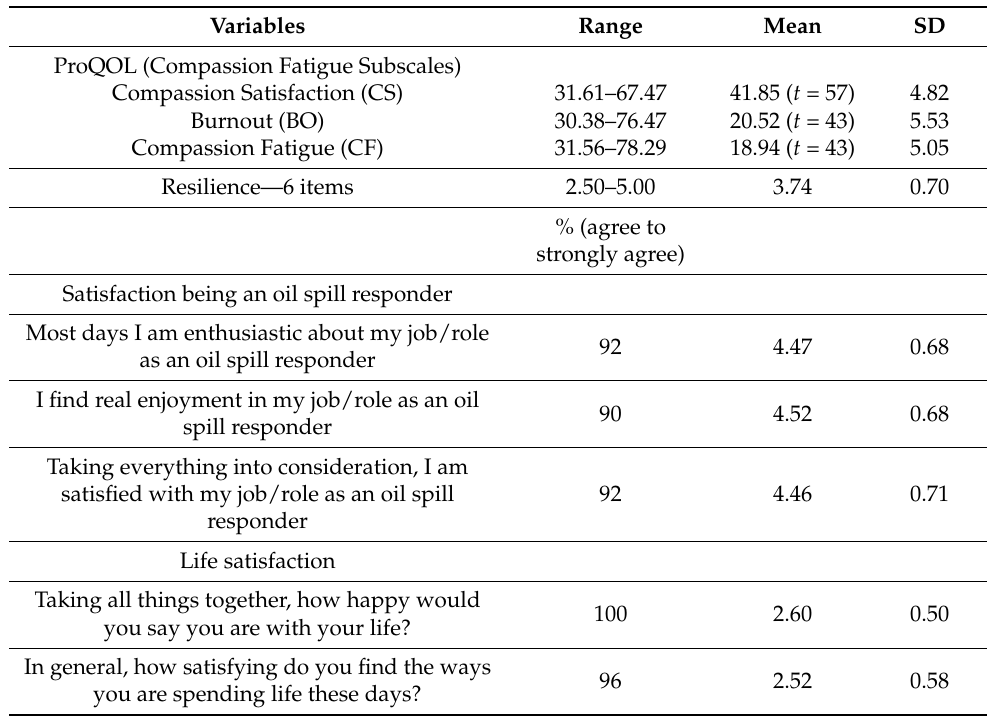
Table 4. Descriptive statistics for ProQOL, resilience, role satisfaction and life satisfaction for all participants.